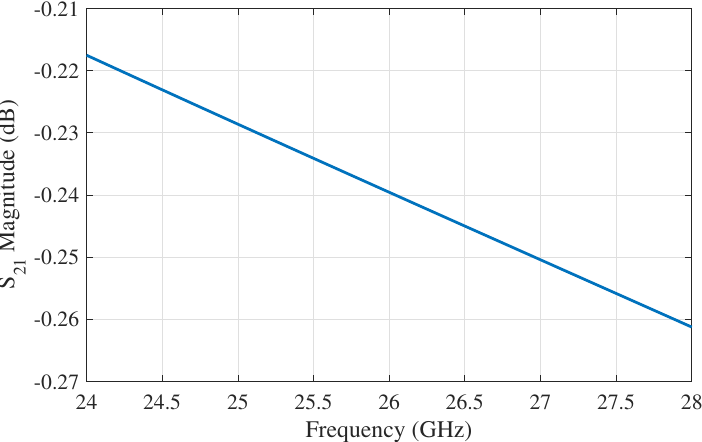
Figure 9. S 21 magnitude as a function of frequency for the microstrip input of the PCB (port 1) to package stripline transition (port